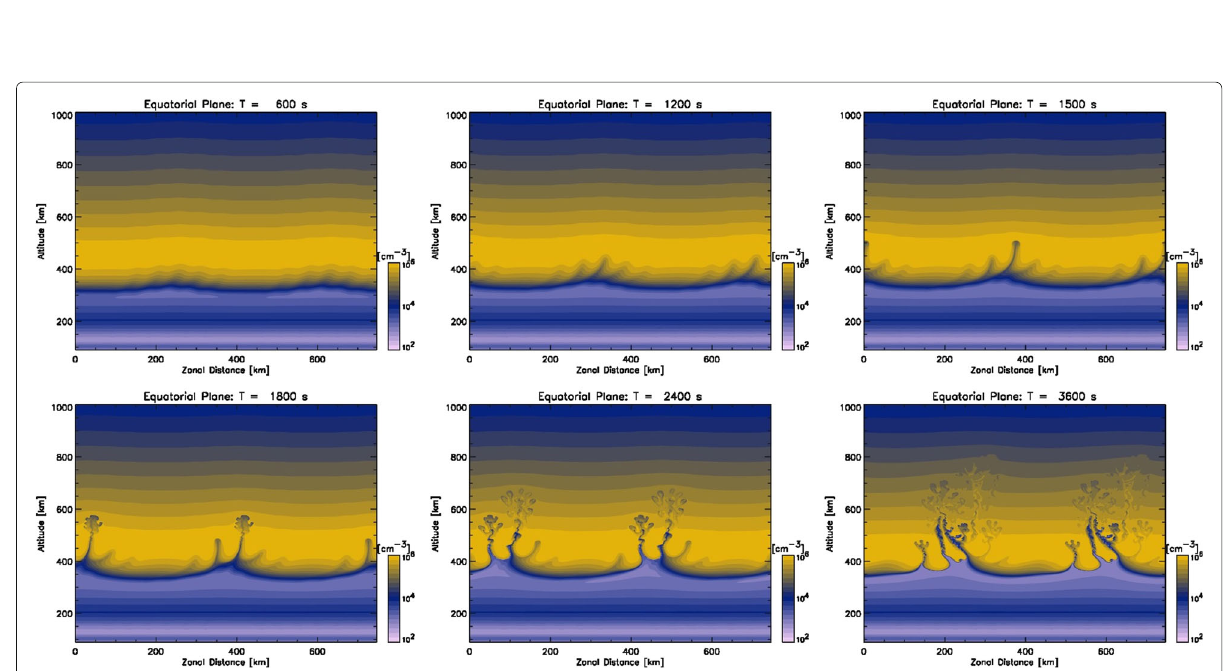
Fig. 8 East–west asymmetry of EPBs simulated using the HIRB model. Reproduced from Yokoyama et al.